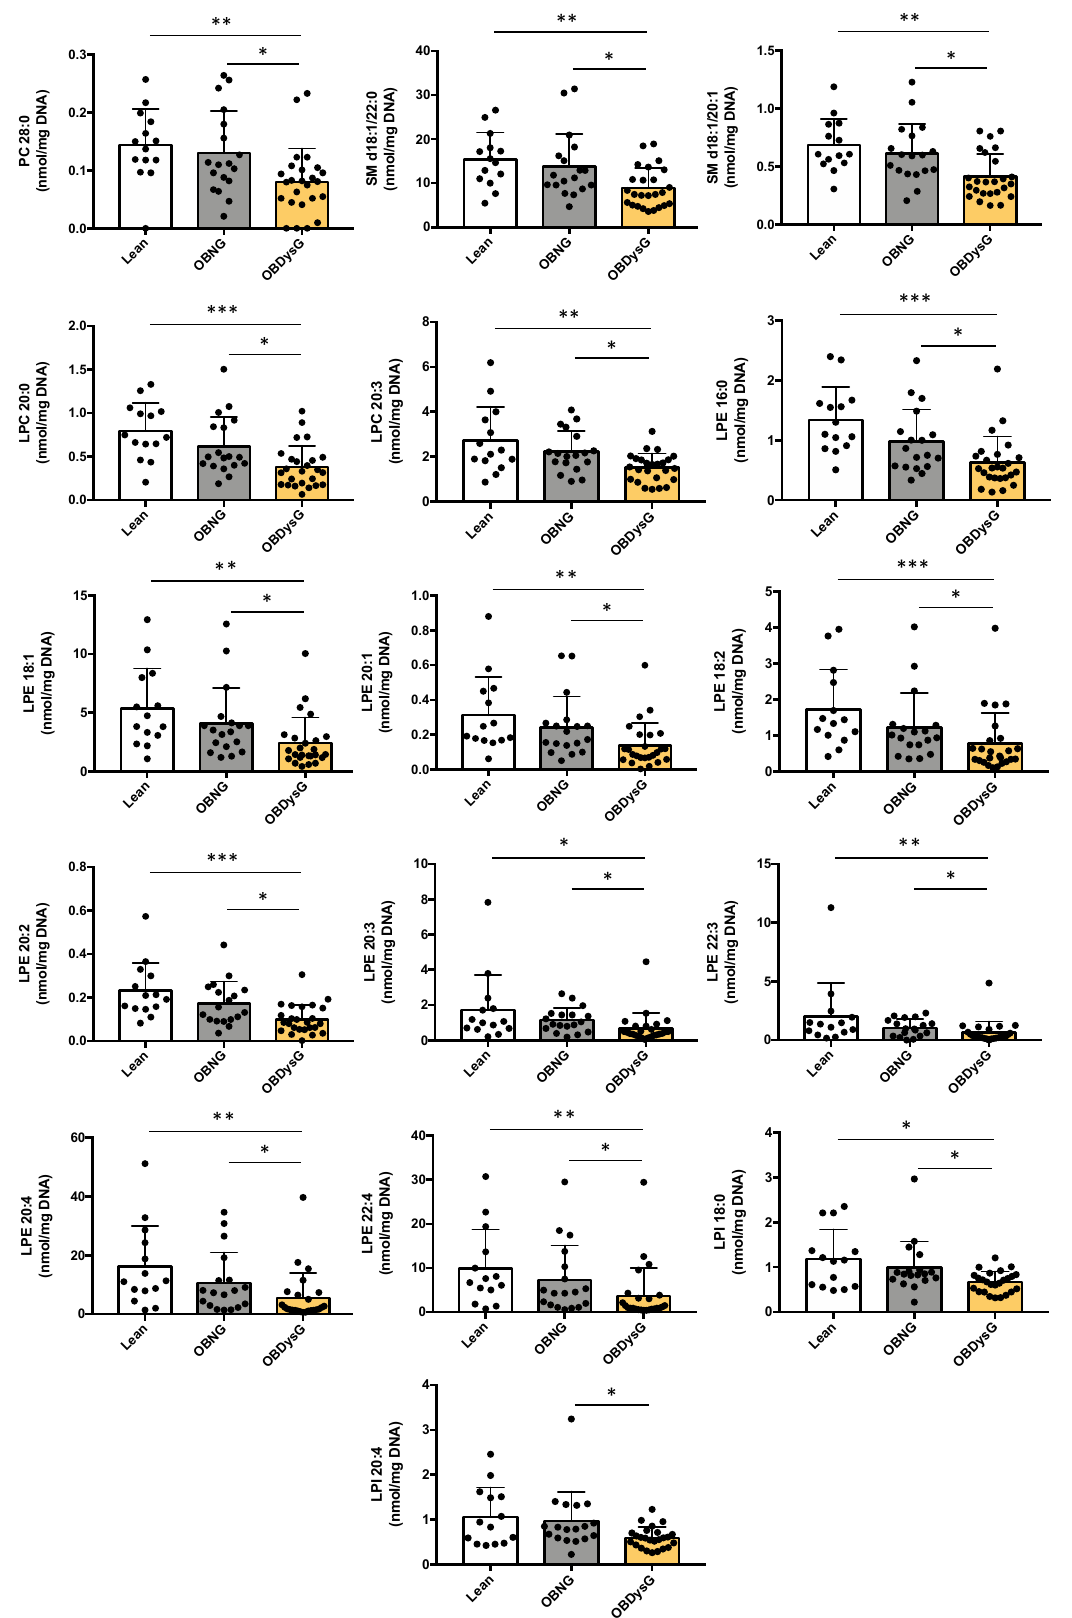
Figure 5. Individual lipid species downmodulated in PBMCs from OBDysG compared to OBNG patients. Data are mean ± SD. * p ≤ 0.05; ** p ≤ 0.01; *** p ≤ 0.001. Kruskal–Wallis followed by Dunn post hoc test was performed on data.